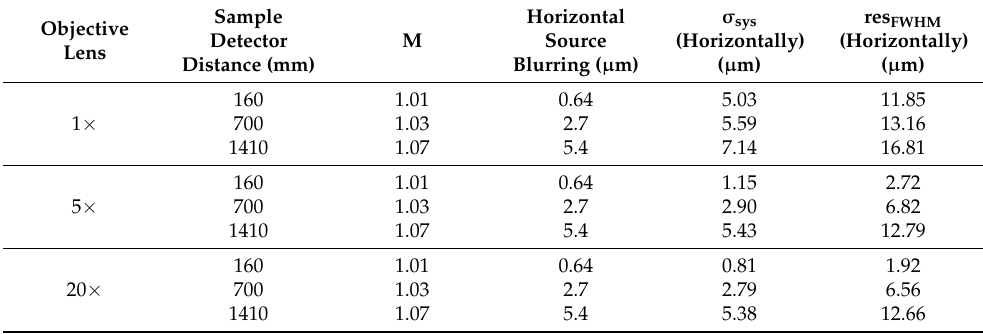
Table 2. The calculated system standard deviation, σ sys , and res FWHM in horizontal direction of MCT white-beam